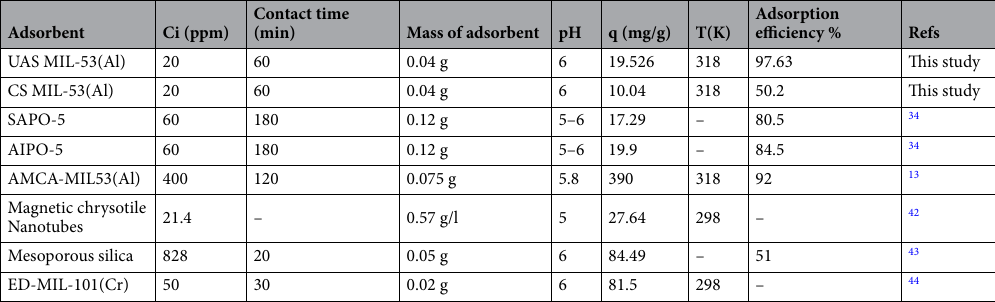
Table 5. Comparison of adsorption parameter for Pb(II) on different adsorbents.